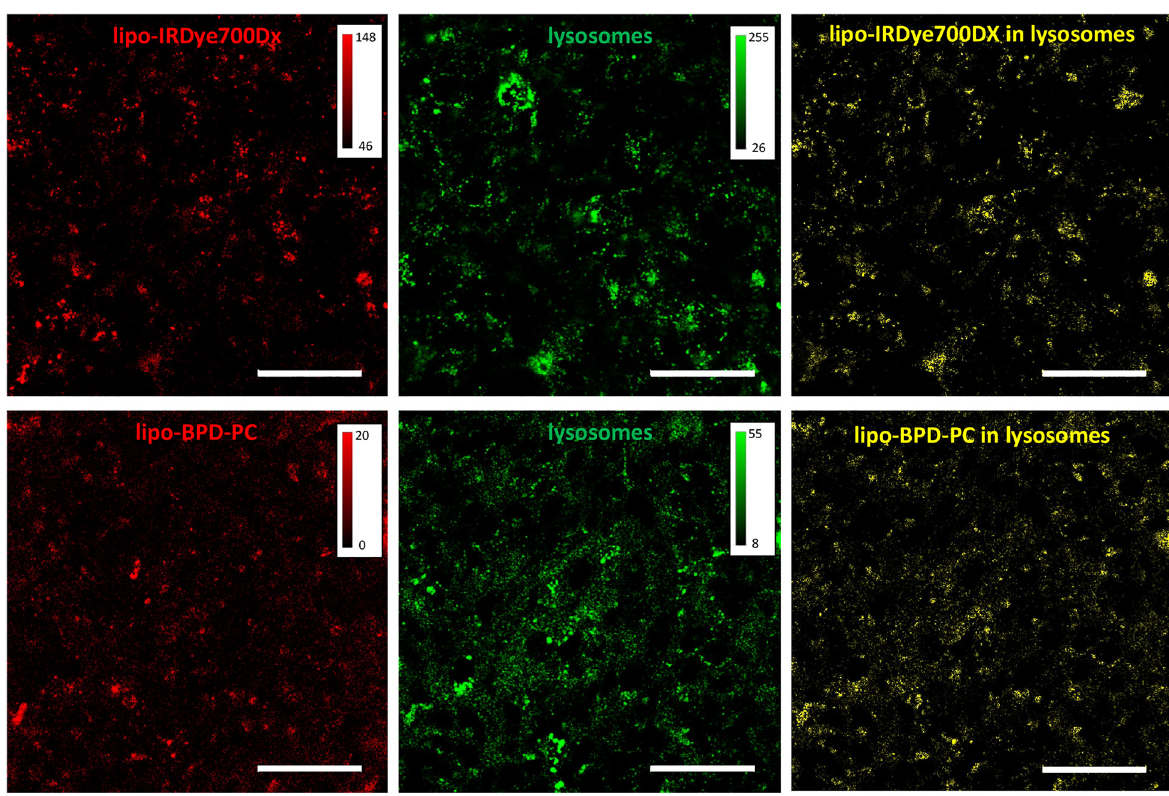
Figure7: Confocalmicroscopyimagesof FaDucellsat 60 × magni fi cation aftera 24hincubationwith lipo-IRDye700DX(top,red),lipo-BPD-PC (bottom, red), and LysoTracker ™ Green DND-26 (middle, green). The liposomes co-localized with the lysosomes are presented in the processed logical AND operator images (right, yellow, processed on ImageJ). (Scale bars are 50